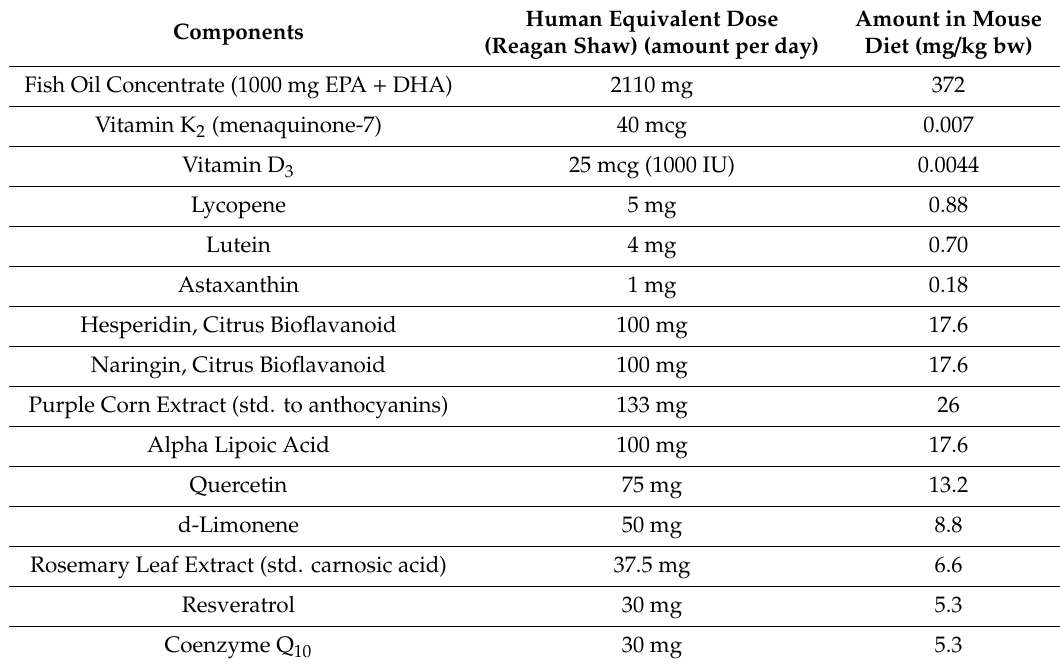
Table 1. Micronutrient blend